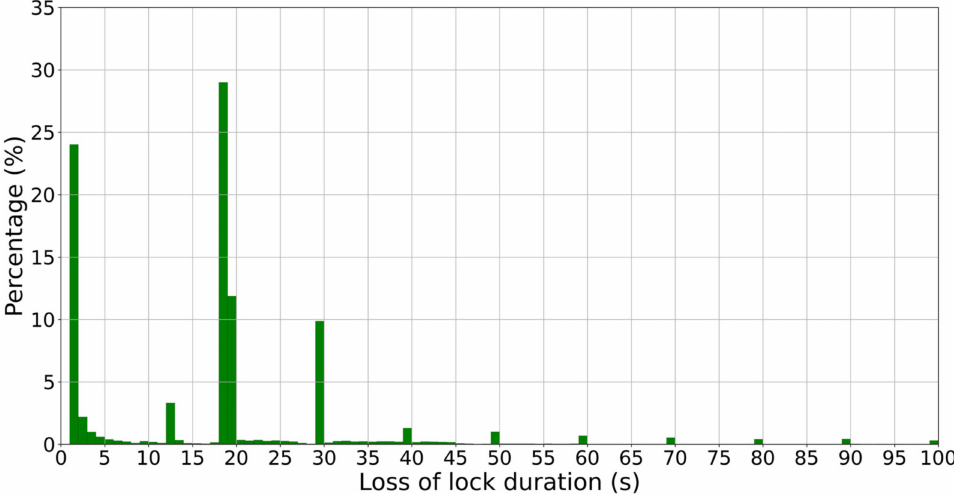
Figure 2. Distribution of the duration (in seconds), between 1 and 100 s, for the cumulative dataset of LoL events suffered by Swarm A, B, and C, between December 2013 and December 2020. Results are given as percentage of occurrence in bins one-second wide. The total number of LoL is